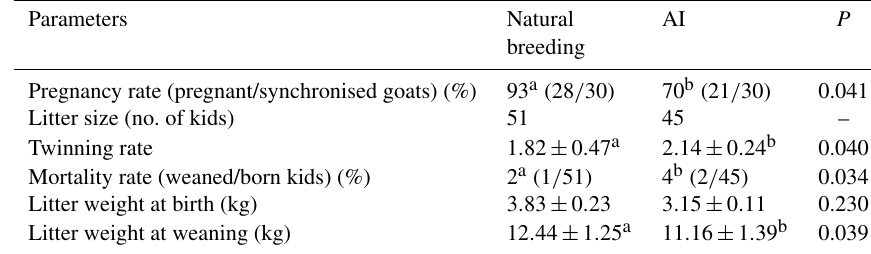
Table 1. Reproduction parameters of naturally and artificially (AI) inseminated Alpine goats. Parameters Natural